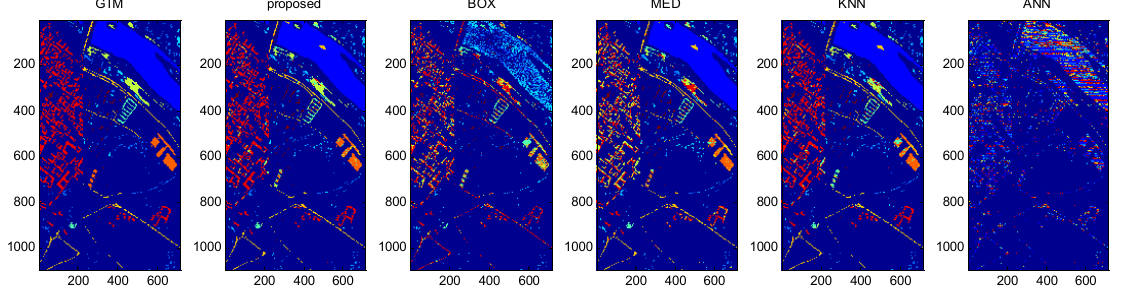
Figure 6. Ground Truth Map (GTM) and classification maps for center of Pavia Image